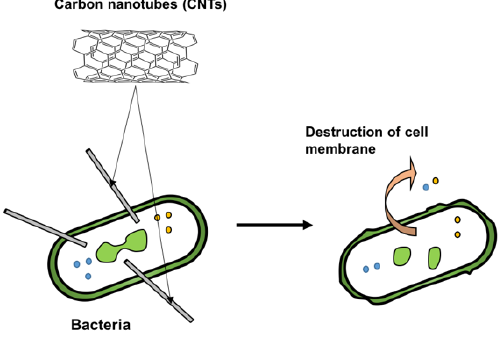
Figure 9. Proposed mechanism of action of CNTs against bacteria.